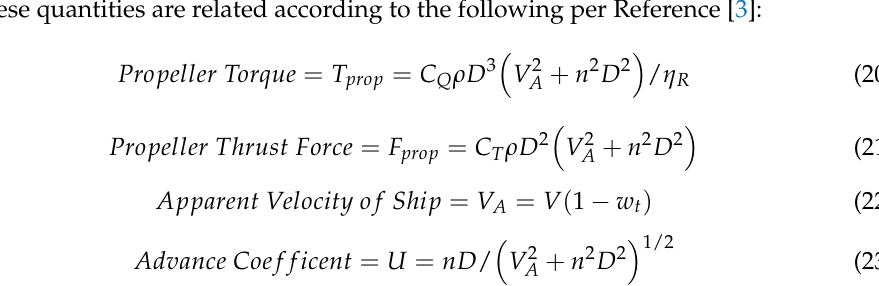
Figure 12. Shaft torque coefficient vs. advance coefficient.